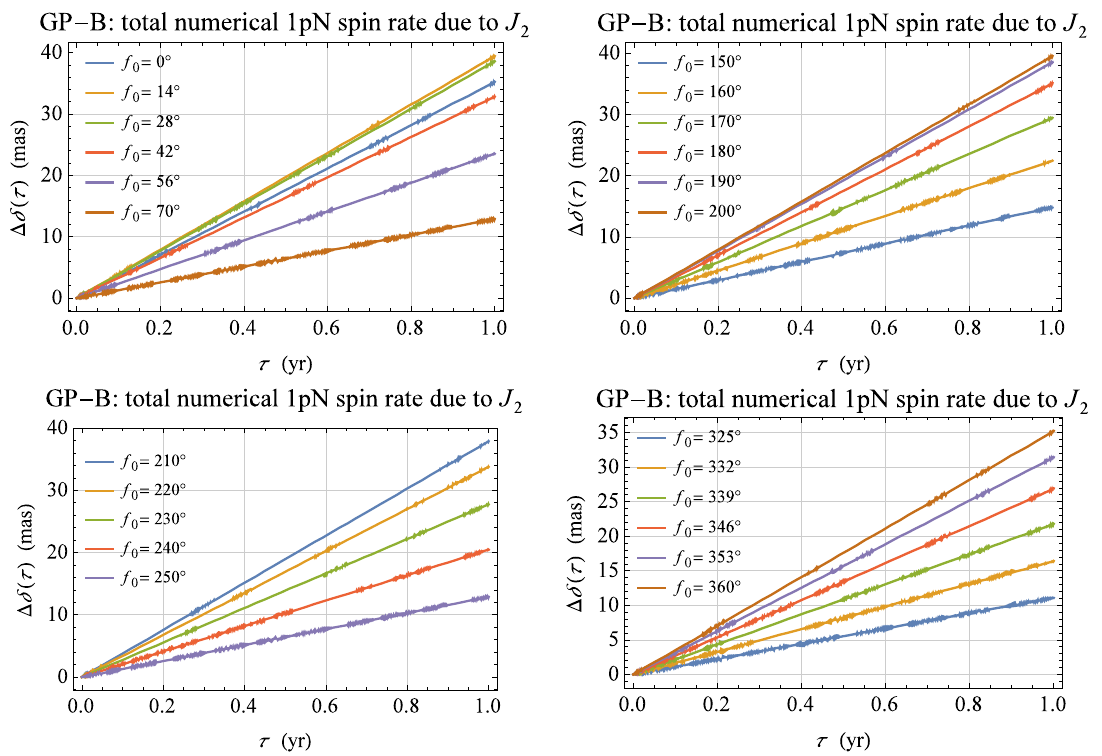
Figure 3. Numerically produced full 1pN J 2 -induced yearly shifts ∆ δ ( τ ) of the declination δ of the spin axis of a gyroscope orbiting the oblate Earth along a realistic precessing Keplerian ellipse for different values of the true anomaly f 0 . Each of the time series ∆ δ ( τ ) was obtained by simultaneously integrating Equation(1) and Equation(4), both with J 2 (cid:54) = 0 in Equations (5)–(9) and subtracting the corresponding de Sitter trends from each of them, and calculating arcsin S z ( τ ) for the resulting solution S z ( τ ) of each run. The initial conditions adopted, common to all of the integrations, were those of GP-B [25], summarized in Table1. All the numerically integrated shifts agree with those calculated analytically in Section3.3 to within (cid:46) 5–8masyr − 1 . Such a discrepancy is not statistically significative = 18.3masyr − 1 since it is smaller than σ GP − B ˙ δ